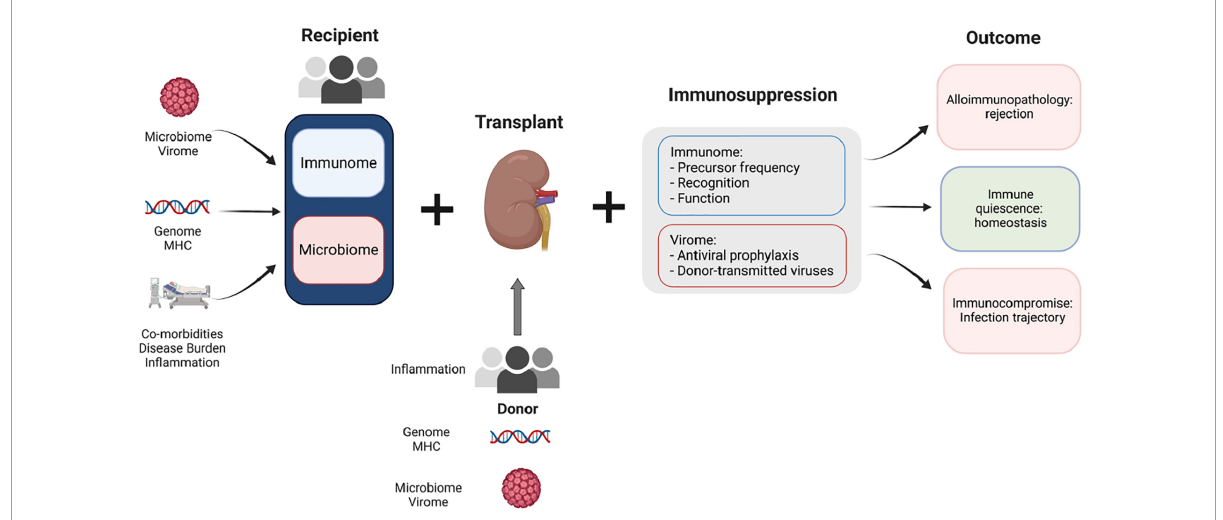
FIGURE1 Complex factors play a role in kidney transplant recipient outcomes. Baseline factors at the time of transplantation for both donor and recipient determine the immune micro-environment in the transplant recipient. Modulating factors such as immunosuppression and antiviral prophylaxis moderate the recipient response to this disturbance. The interplay between the fixed baseline characteristics of donor and recipient and modifiable features (immunosuppression) determines the outcome for each transplant